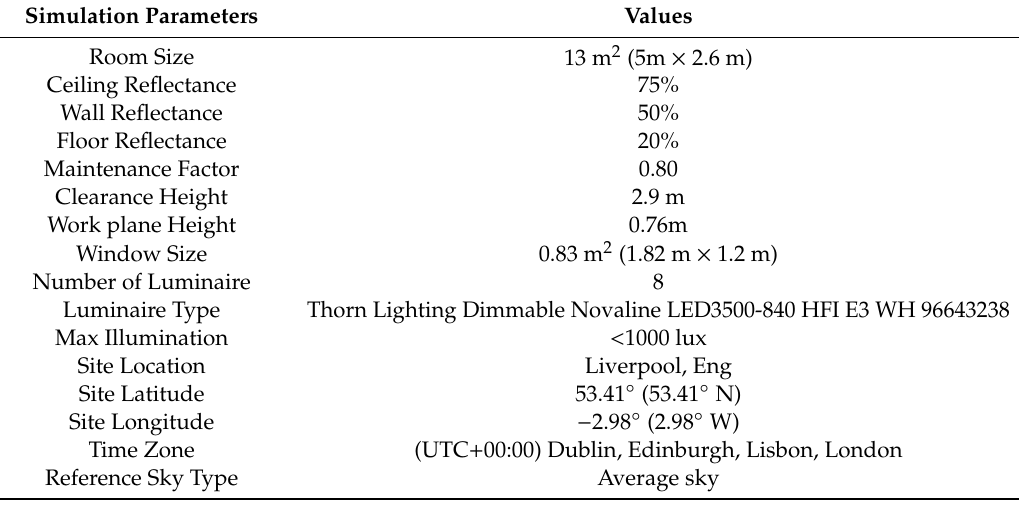
Table 2. Simulation parameters and